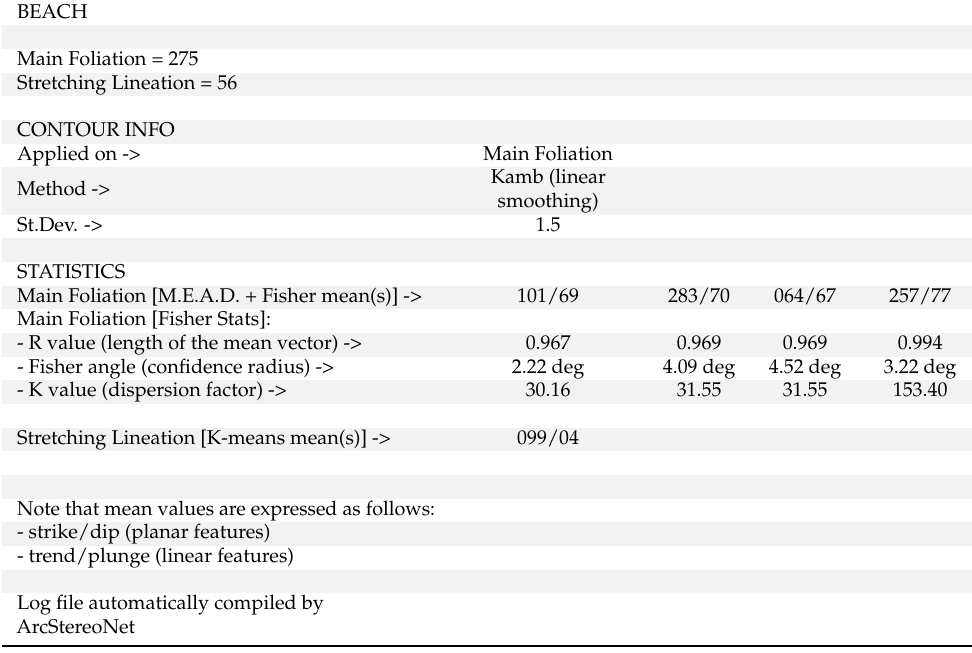
Table A5. ‘Beach’ station log file. The original .txt file has been converted to table format. BEACH